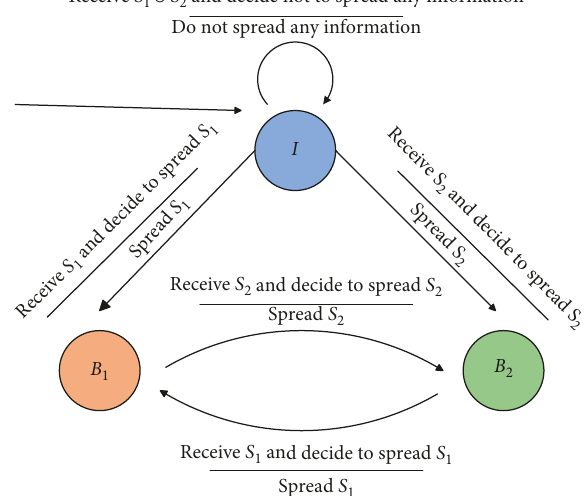
Figure 1: The state transition diagram of the propagation process for two pieces of competitive